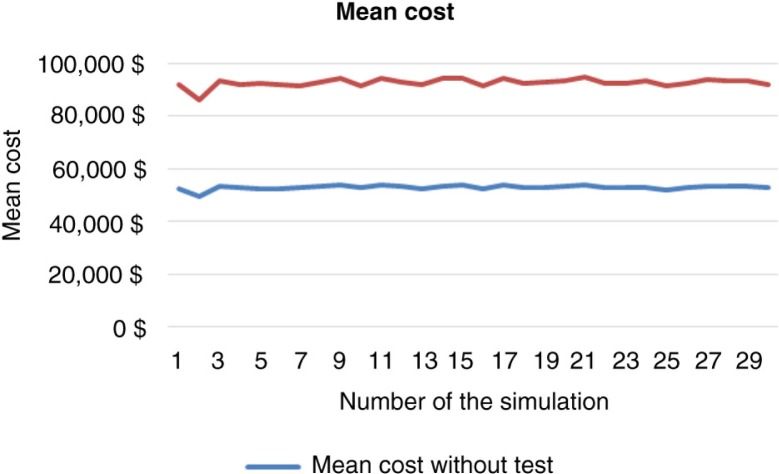
Mean anti-TNF-therapy cost distribution by simulation (10,000 patients, 5 years).